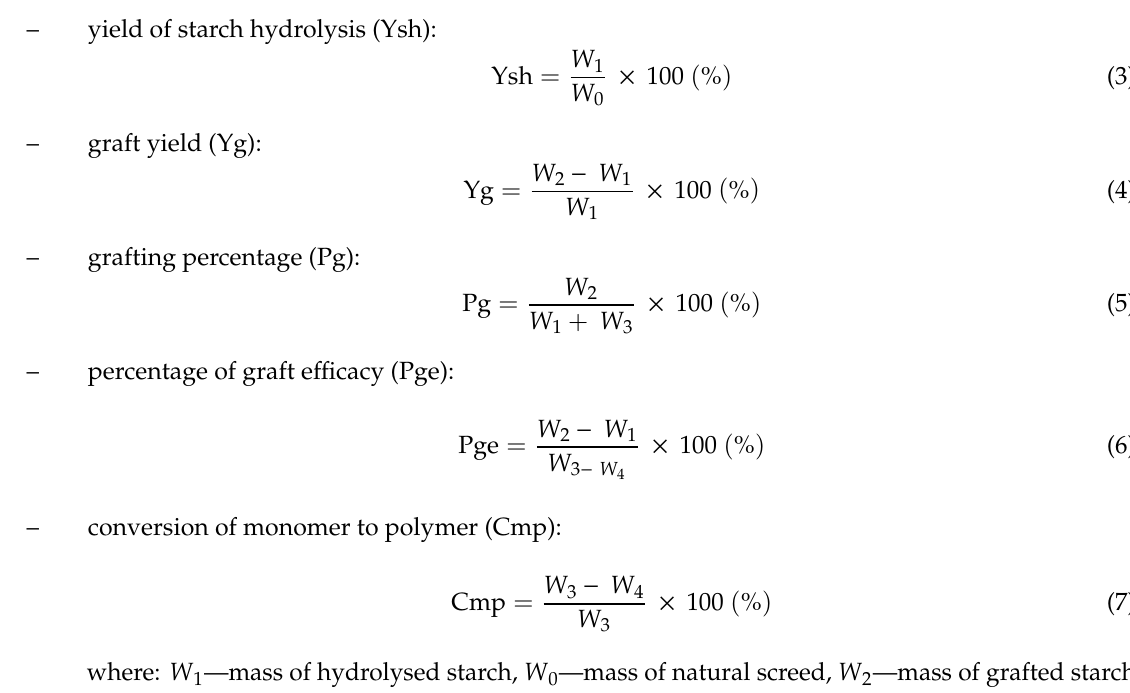
grafted starch. FTIR spectra of the grafted samples the most e ffi cient associated initiator such as: